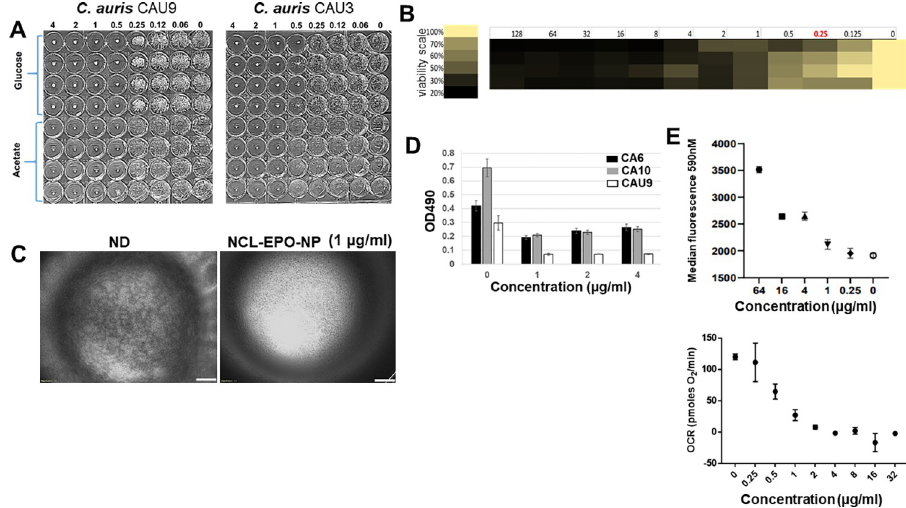
Fig 7. NCL-EPO-NP prevent growth of planktonic C . auris , increase ROS activity, and negatively affect oxygen consumption rates in C . albicans . (A) Dose response assay using round bottom 96-well microtiter plates showed that NCL-EPO-NP could prevent growth of 2 different strains of C . auris (CAU-9 and CAU-3) in YP+1% acetate as well as in YP+1% glucose at concentration of 0.5 to 1 μ g/ml. (B) The same dose, 1 μ g/ml and above, could also prevent growth of C . auris biofilms, measured by XTT reduction assay, and portrayed in a heat map where darker colors indicate increased fungal killing while yellow means fungal viability (4 replicates are shown). (C) NCL-EPO-NP at 1 μ g/ml inhibited C . auris biofilm formation (bottom of the 96 well was microscopically visualized 2X mag. Scale bar = 500 μ m). (D) NCL-EPO-NP at low concentration could prevent biofilm growth of fluconazole-resistant C . albicans strains CA-6, CA-10, and fluconazole-resistant C . auris CAU-9. Results are from XTT assay with 3 replicates. (E) Increasing concentrations of NCL-EPO-NP correspondingly increased ROS production in C . albicans , which was measured by staining with MitoSox red with the resulting fluorescence read at 590 nM by using a flow cytometer. (F) Increasing concentrations of NCL-EPO-NP also abrogated the oxygen consumption rate in C . albicans , which was measured using a Seahorse assay. Raw data are found in the file S1 Data. NCL-EPO-NP, NCL-loaded EPO NP; ROS, reactive oxygen